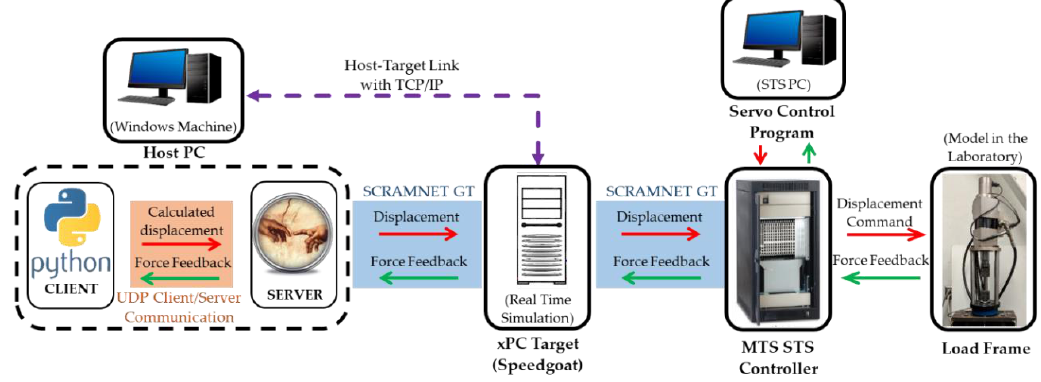
Figure 3. HS/RTHS communication scheme for Python-based analytical substructure (metamodel) modeled in Local